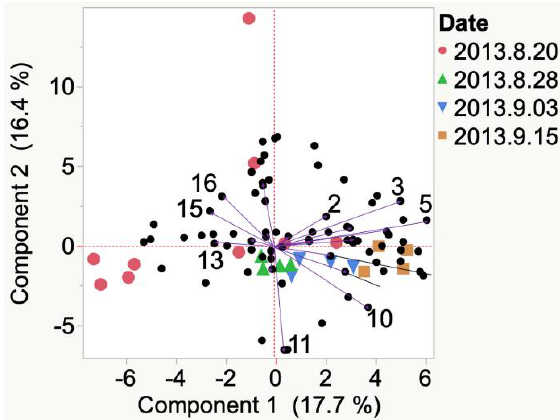
Figure 12. Evolution of VOCs emitted from crushed berries from veraison to harvest of 2012 and 2013 La Crescent grapes grown in South Dakota. Key to most representative volatiles from HCA, shown as vectors from the origin and read clockwise: 1 = Furfural, 2 = Isobutyraldehyde, 3 = Benzaldehyde, 4 = Ethyl vinyl ketone, 5 = Toluene, 6 = Camphene, 7 = Ethyl butyrate, 8 = Propyl-Benzene, 9 = Styrene, 10 = Hexanal, 11 = beta-Pinene, 12 = Isoamyl acetate, 13 = Carbon disulfide, 14 = Linalyl acetate, 15 = 2-Ethyl-1-hexanol, 16 = Geraniol, 17 = Isophorone, 18 = Allyl alcohol.